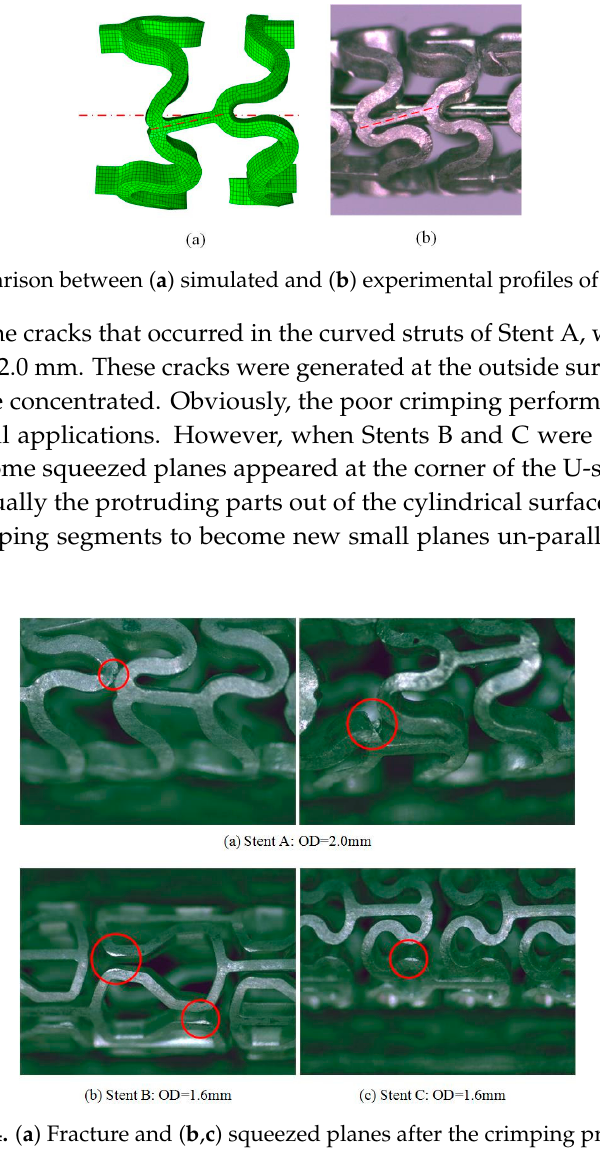
Figure 12. Experimental profiles of ( a ) Stent A, ( b ) Stent B, and ( c ) Stent C after crimping to outside diameters of 2.0 and 1.6 mm.